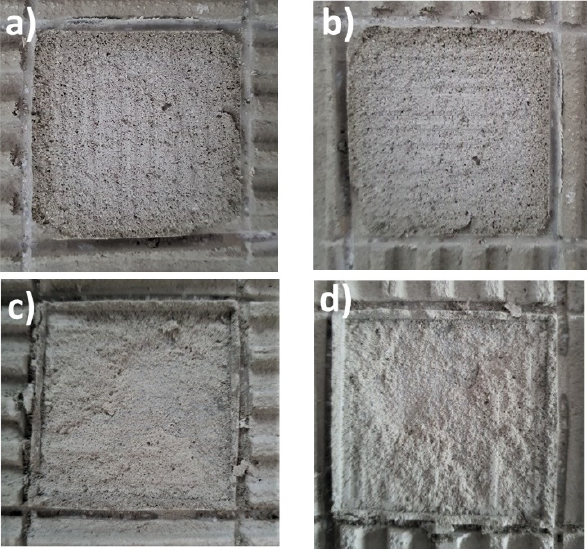
Figure 5. Appearance of adhesion surface (after tearing off the ceramic tile) in tensile adhesion strength test: ( a ) initial test, ( b ) after thermal impact, ( c ) after water impact, ( d ) after freeze/thaw cycles.